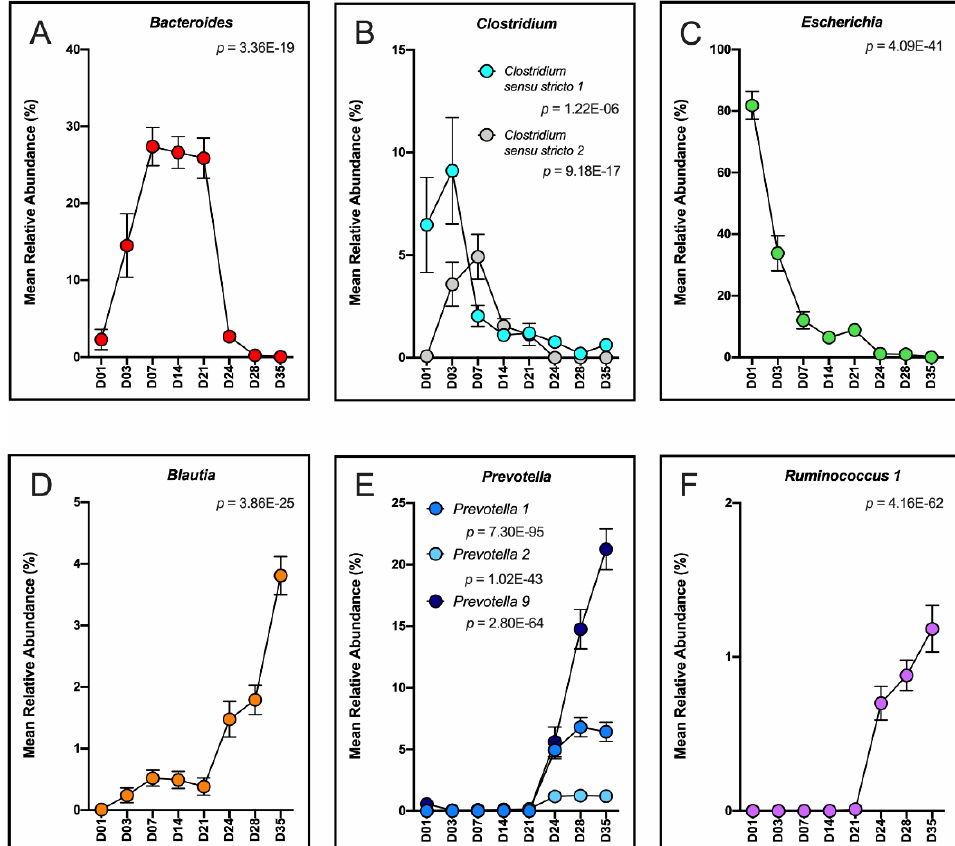
Figure 5. Differentially abundant genera in the piglet pre- vs. post-wean fecal bacteriome. Trends in mean relative abundances of significant bacterial genera representing the ( A – C ) pre-wean (D01–21) and ( D – F ) post-wean (D24–35) piglet fecal bacteriome. FDR-corrected p-values were calculated using a linear mixed-effect regression model in the R-package DAtest controlling for individual piglet and litter. Error bars represent ± SE. A complete list of differentially abundant bacteria is found in Table S5A.